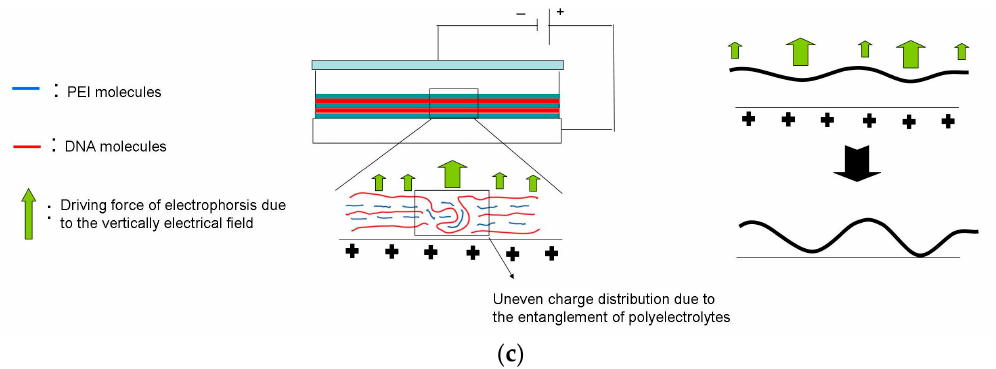
Figure 5. Atomic force microscopy analysis of PEMs. ( a ) Surfaces of PEMs before or after treating different voltages for 1 h. ( b ) Surfaces of PEMs in aqueous environments with or without electrical field treatment for 1 or 2 h. Roughness averages (Ra) were also determined ( n = 3, and t -test compared to the 0 V group, * p < 0.05) ( c ) The explanation scheme of surface roughness after vertically electrical field treatment. Entanglement of polyelectolytes caused uneven charge distribution, and these unstable regions were susceptible to electrical fields to demonstrated quick release. In addition, the thinner regions became closer to the electrode, which thus were released faster to eventually form bumps and nanoparticles on the PEM surfaces.